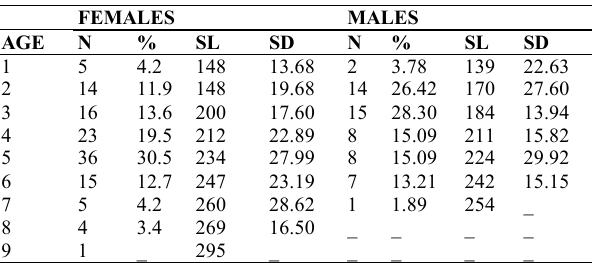
Table 2 . Age and sex structure of L. acutidens. N = number of individuals sampled, SL = standard length (mm) SD = stan- dard deviation. In order to compare sizes of males and fe- males, the t test of unpaired samples was used. Significant results (P<0.05) are emphasized with an asterisk.